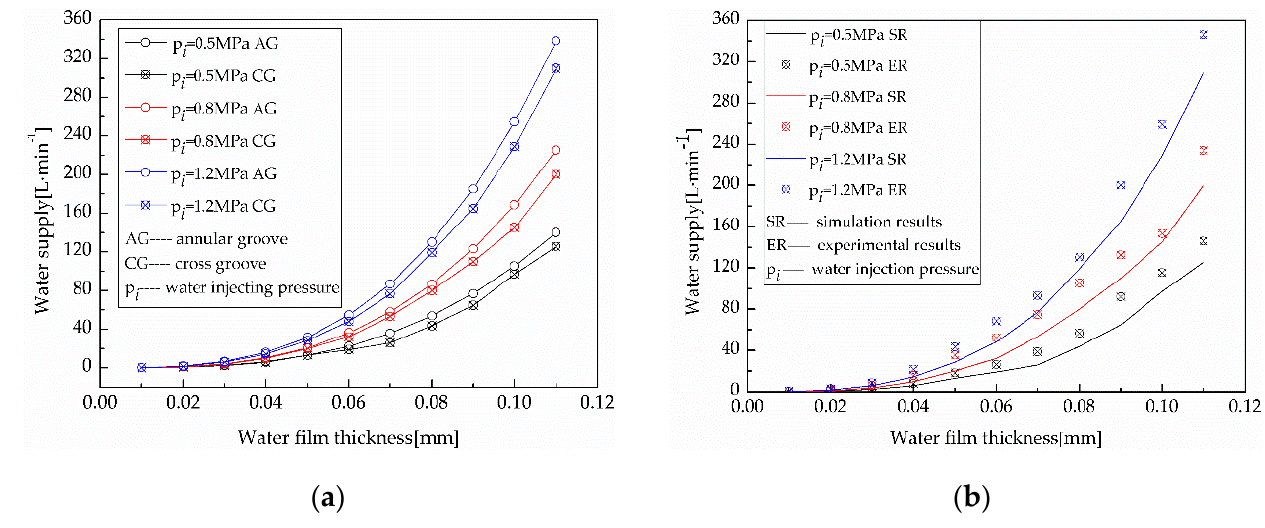
Figure 14. Comparison of the water supply for ( a ) annular groove vs. crossing groove (simulated results), ( b ) crossing groove (simulated results vs. experimental results).